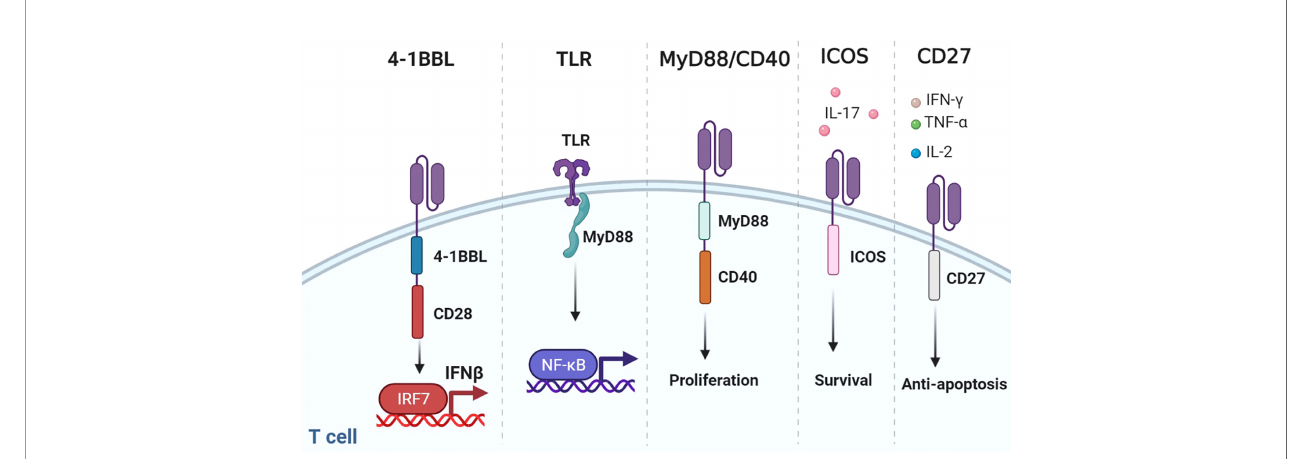
FIGURE 5 | Representative designs of CARs with co-stimulatory domains. Diagrams of CARs with co-stimulatory domains. 1) Co-expressing 4-1BBL and CD28 could recruit the host immune response against the tumor through the IRF7/IFN- b pathway. 2) TLR could combine MyD88 to activate NF- k B. 3) MyD88/CD40 promoted T-cell proliferation. 4) ICOS increased the production of IL-17 and enhanced the survival of T cells. 5) CD27-based CAR-T cells secreted Th1 cytokines (IFN- g , TNF- a , and IL-2) and were resistant to apoptosis. Figure created using